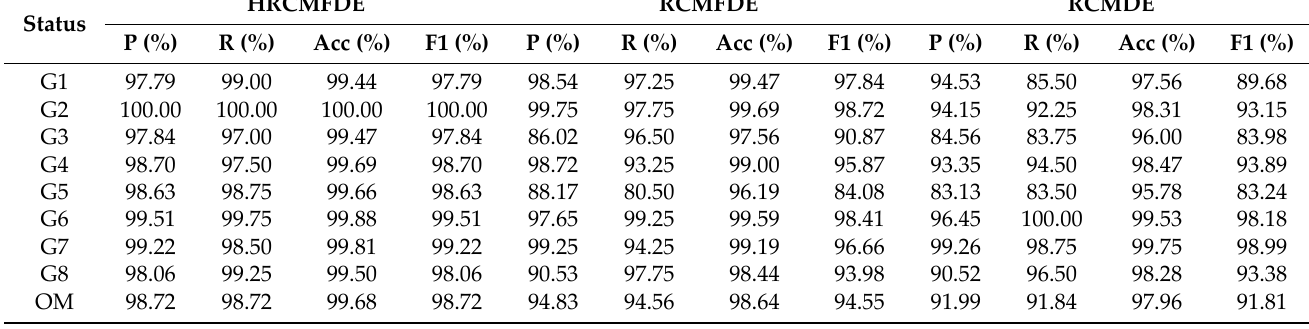
Table 6. Comparison of different models.